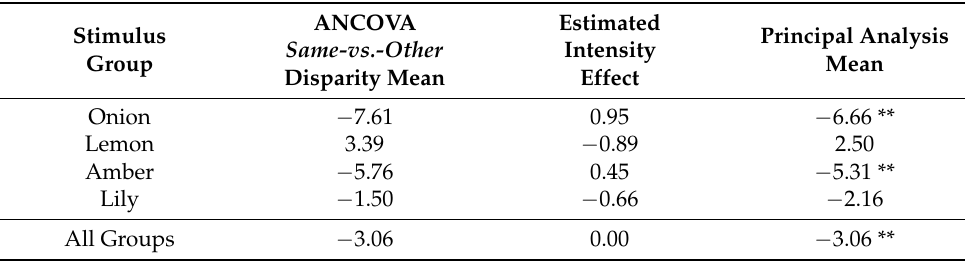
Table 3. Mean same-vs.-other disparities in the principal analysis (composed of estimated ANCOVA means plus odorant intensity